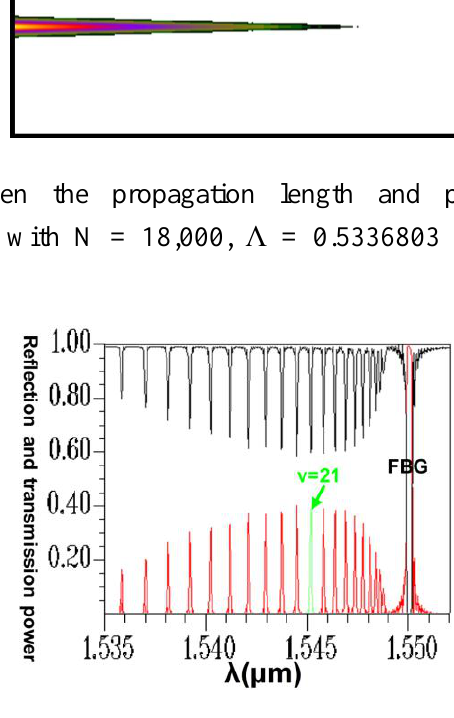
+ L + L = 9,806.2454 μm. 1 2 3